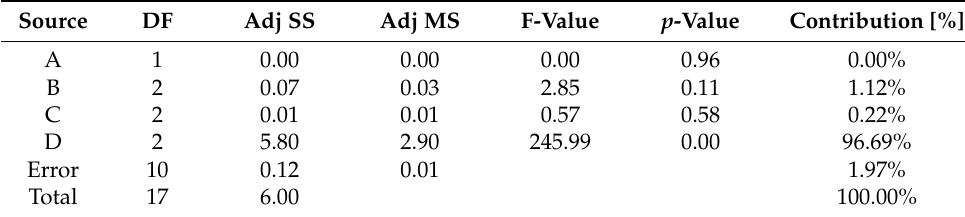
Table 8. ANOVA for tensile strength.